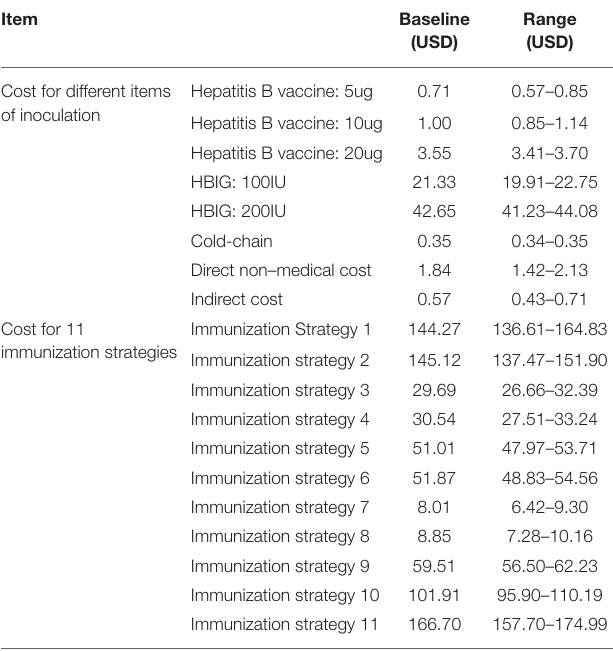
TABLE 4 | Cost for 11 immunization strategies (in